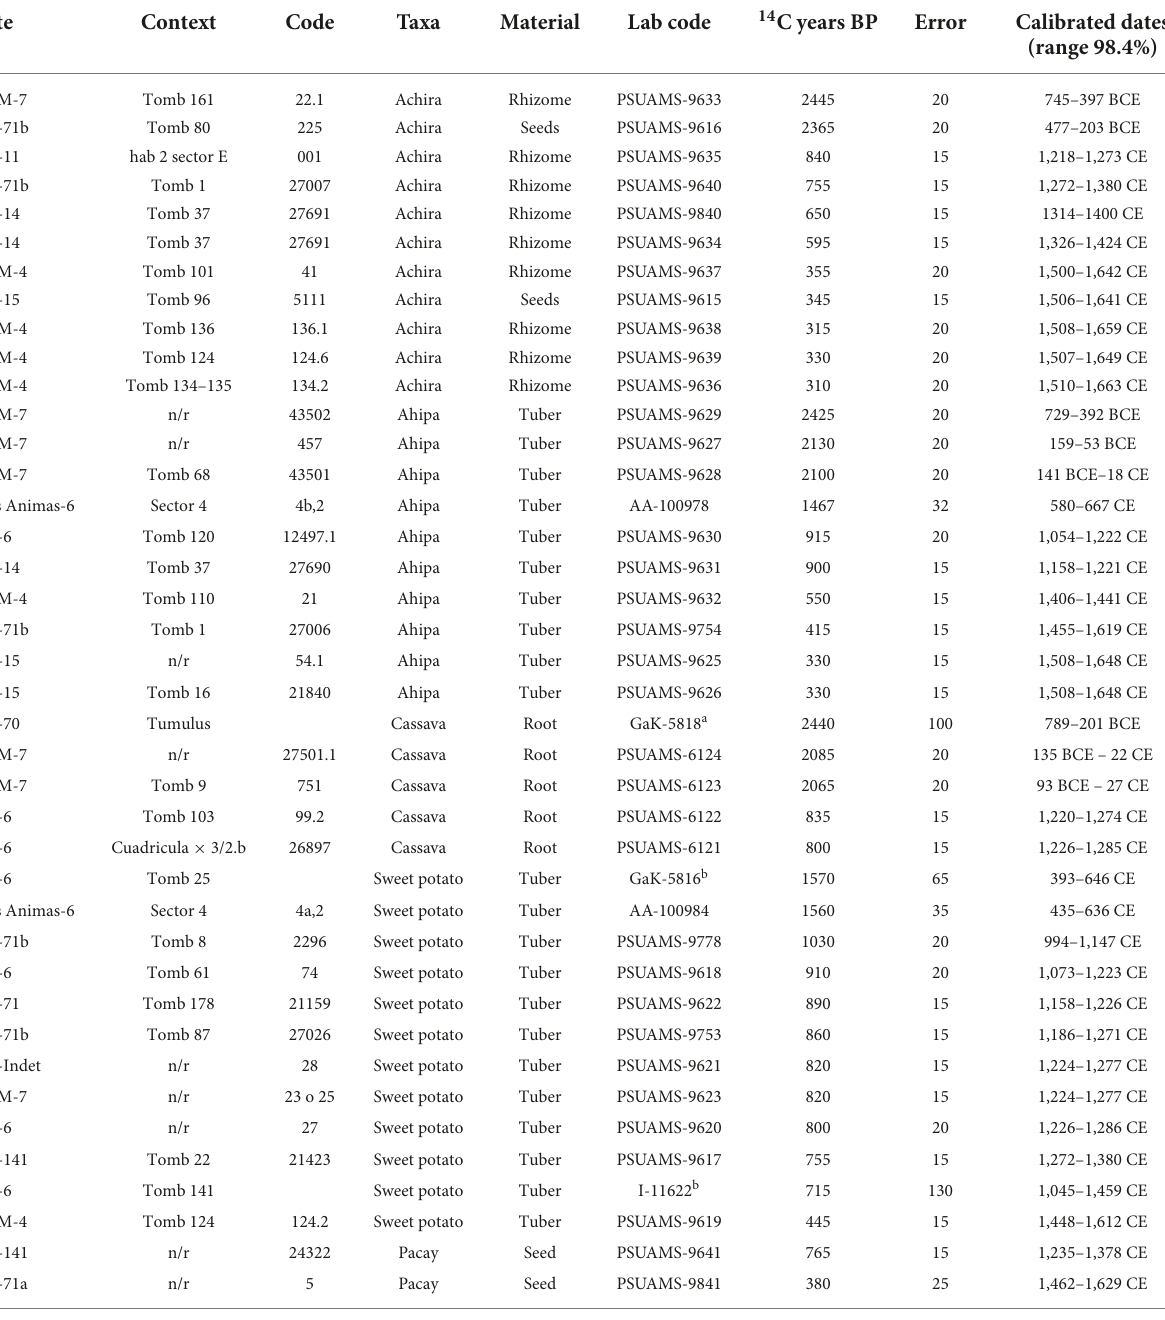
TABLE 3 Results of direct accelerated mass spectrometry radiocarbon dating including calibrations carried out using Oxcal 4.4 (Bronk Ramsey, 2021) and the southern hemisphere calibration curve (Hogg et al.,